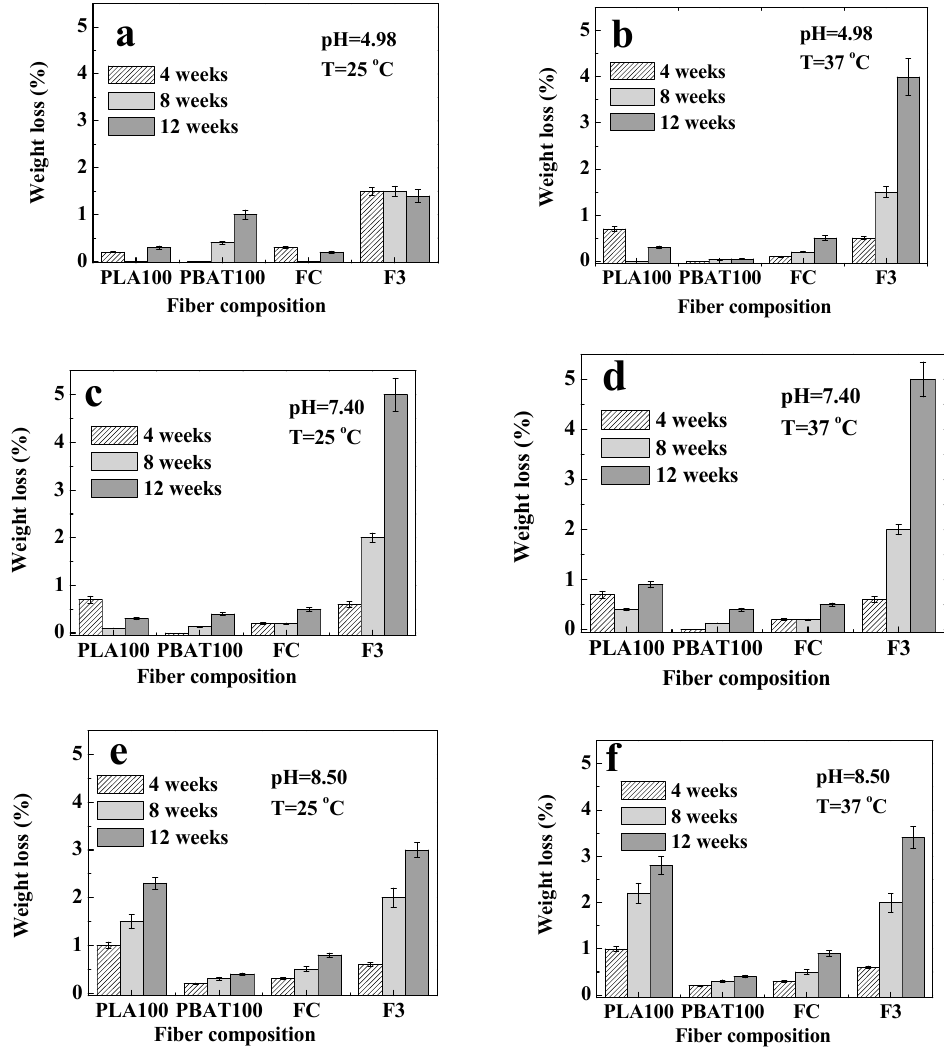
Figure 7. Fiber weight loss at 4, 8, and 12 weeks for: pH = 4.98 at ( a ) T = 25 °C and ( b ) T = 37 °C; pH = 7.40 at ( c ) T = 25 °C and ( d ) T = 37 °C; and pH = 8.50 at ( e ) T = 25 °C and ( f ) T = 37 °C.